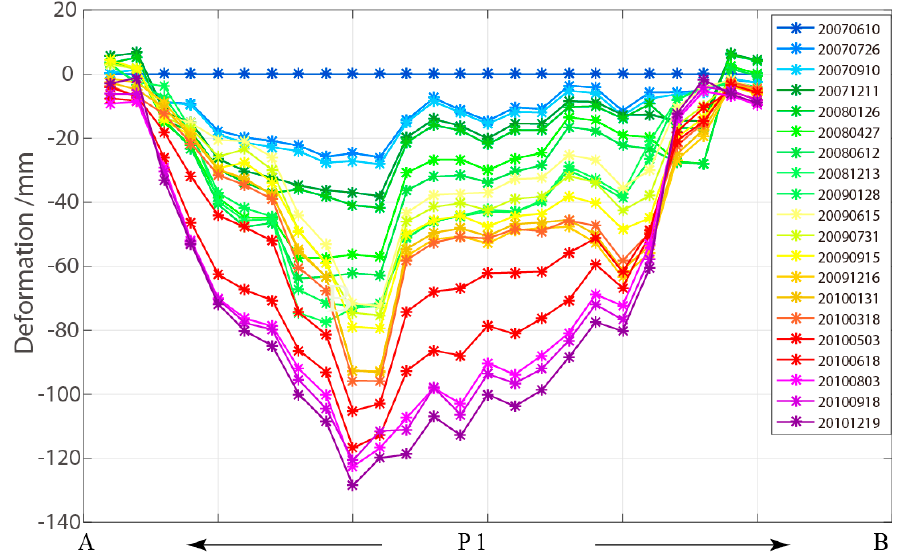
Figure 8. Profile of deformation time-series along the red line in Figure 7c for the selected area P1.